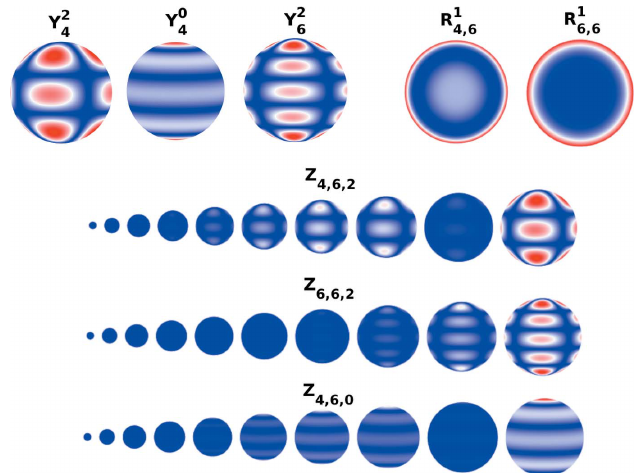
Figure 7 Representation of some components of the basis Z l , n , m regarding their former angular and radial components Y m and R 1 . Since the spherical l l ; n harmonics Y m are only defined on the surface of the sphere, the l representation of the basis components Z l , n , m includes several spheres whose radius is contained in the interval [0, 1] to have a better graphical representation of the whole component. The real component would be obtained by stacking all the spheres (whose radii belong to the interval [0, 1]) concentrically. Each point in the three representations corresponds to the value obtained when evaluating the corresponding functions on a